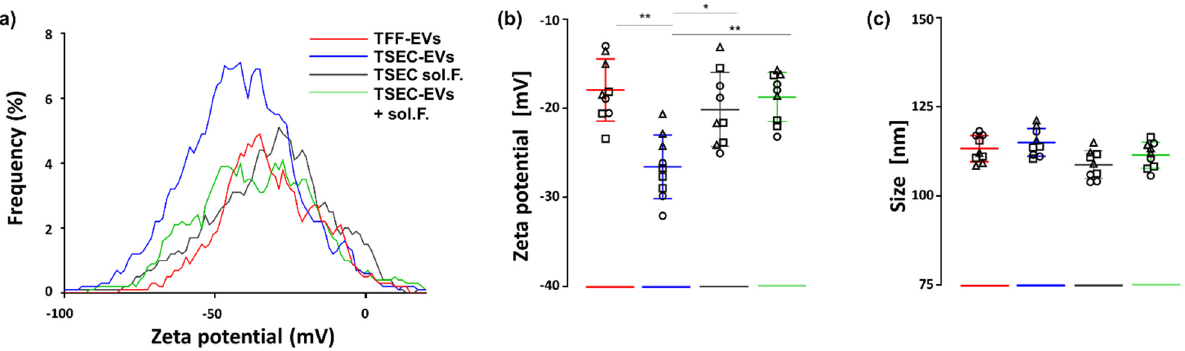
Figure 5. TSEC-EV zeta potential in the absence or presence of a protein-rich environment. ( a ) Zeta- potential frequency distribution (depicted as rolling average) and ( b ) voltage was measured with a ZetaView instrument by evaluating the particles’ migration in a pressure-free environment, strictly by charge. HPL-derived TFF-EVs, TSEC-EVs alone, and TSEC-EVs after add-back of their corresponding TSEC-soluble fractions (TSEC-EVs + soluble fractions) are shown. ( c ) There was no statistically significant difference in particle size. One-way ANOVA, repeated measures, ** p ≤ 0.01, * p ≤ 0.05. Each symbol (circles, squares and triangles) represents a different biological replicate ( n = 3) tested in triplicate.